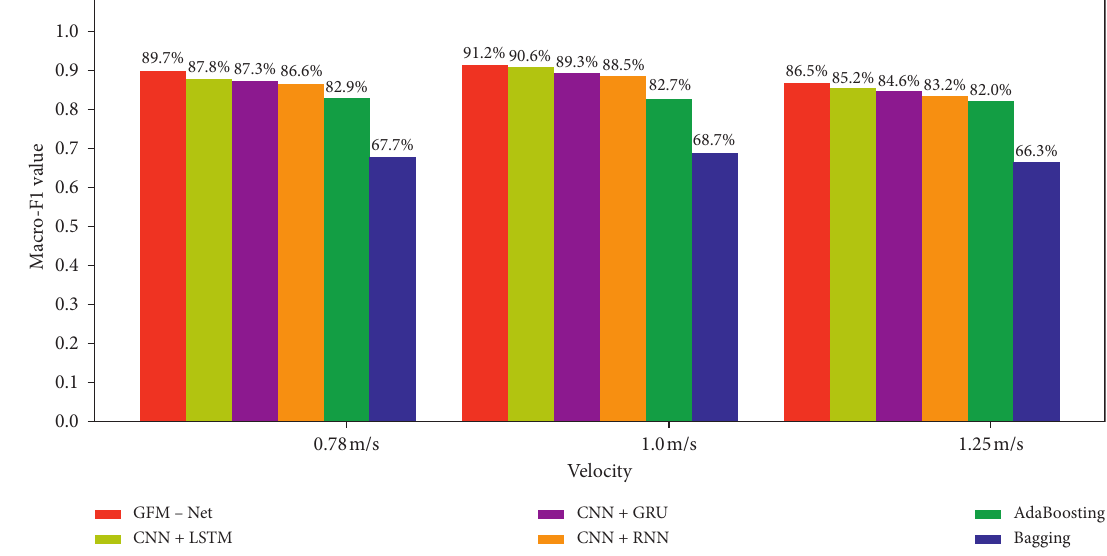
Figure 11: More tag data set classifier macro-F1 distribution under sync speed.